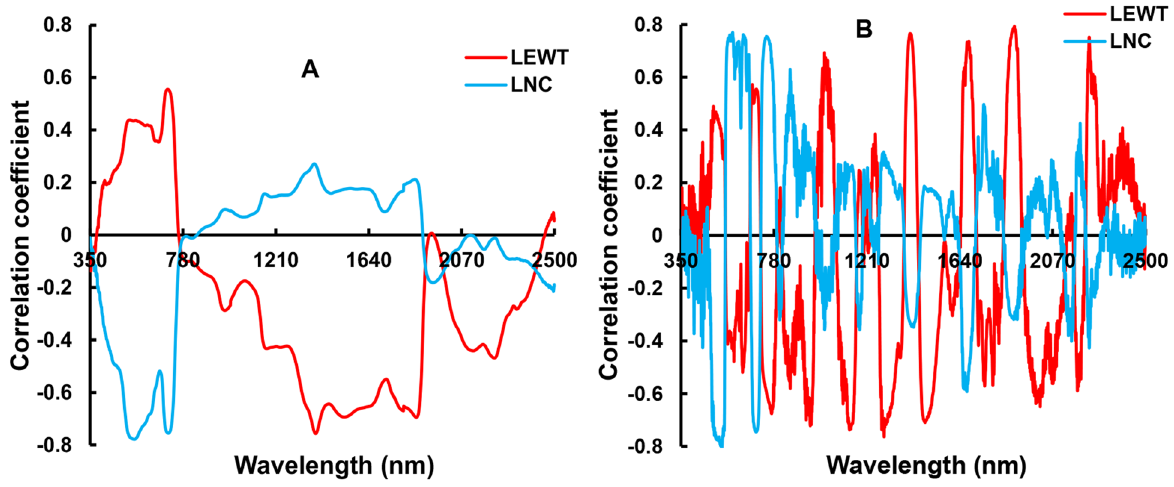
Figure 3. The correlation of LEWT and LNC to original spectral reflectance (A) and its first derivative (B) in Exp. 1.